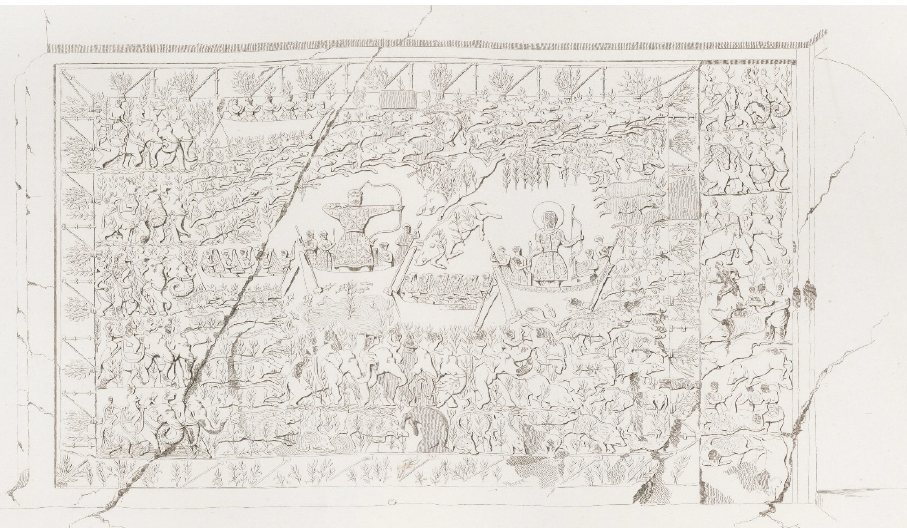
Figure 4. The boar hunt relief, rock relief, end of the 6th century CE, Taq ‐ e Bustan, The Great Grotto. Source: Flandin, E.; Coste, P. Voyage en Perse, Gide et J. Baudry, Paris, France 1851, modified by